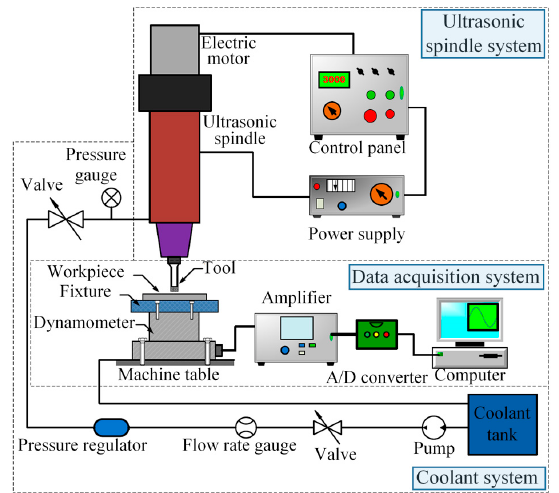
Figure 2. RUM system set-up.